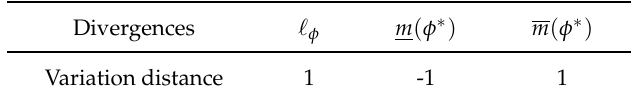
Table 1. Value of (cid:96) φ , m ( φ ∗ ) , and m ( φ ∗ ) for variation distance φ -divergence.